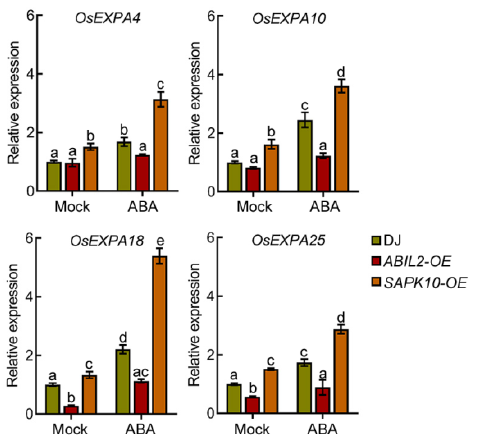
Figure 7. The induction of ABA in the expression of EXPANSIN genes depends on ABA signaling. Quantitative polymerase chain reaction (qPCR) analysis of OsEXPA4 , OsEXPA10 , OsEXPA18 , and OsEXPA25 in 4-day-old Dongjing (DJ), ABIL2-OE , and SAPK10-OE seedling roots treated with or without 1 μM ABA for 3 h. Three biological replicates were performed with similar results and a representative experiment is shown. Samples were collected from three independent experiments. Bars indicate ± SD. Different letters indicate significant differences ( p < 0.05, one-way ANOVA with Tukey’s test).